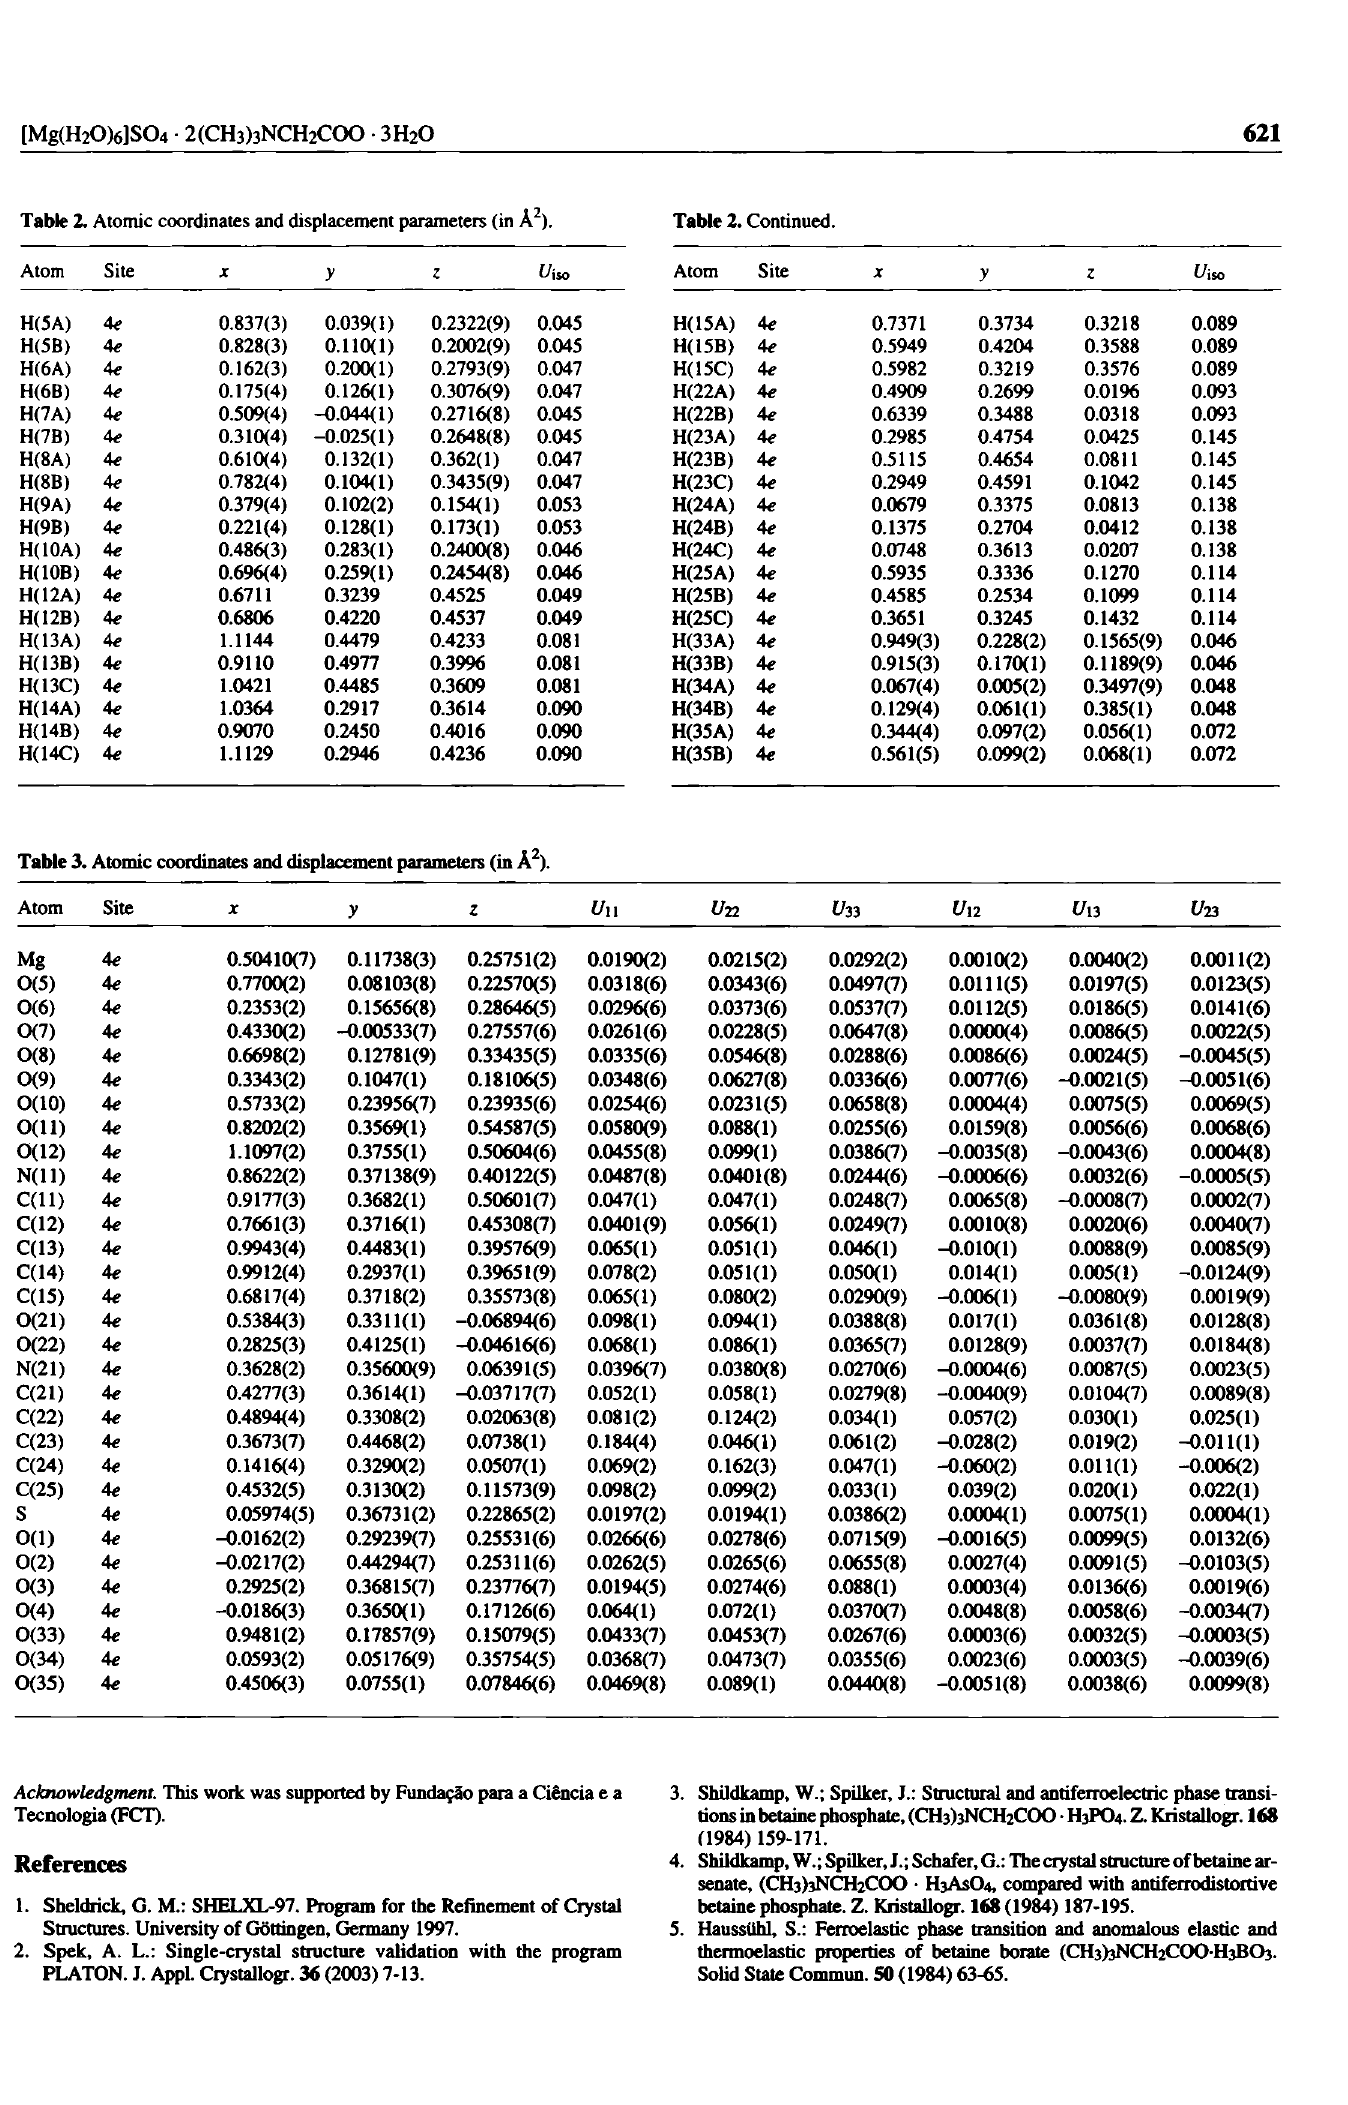
Table 3. Atomic coordinates and displacement parameters (in A 2